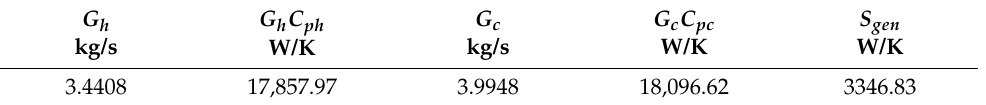
Figure 15. Local entropy generation rates of the four demonstrated cases. Table 6. Heat capacity rates of the streams and respective total entropy generation for the best